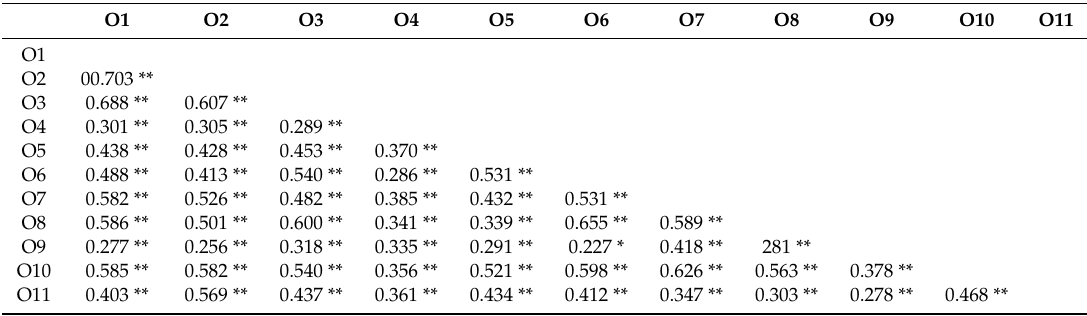
Table 6. Correlations between the items on the